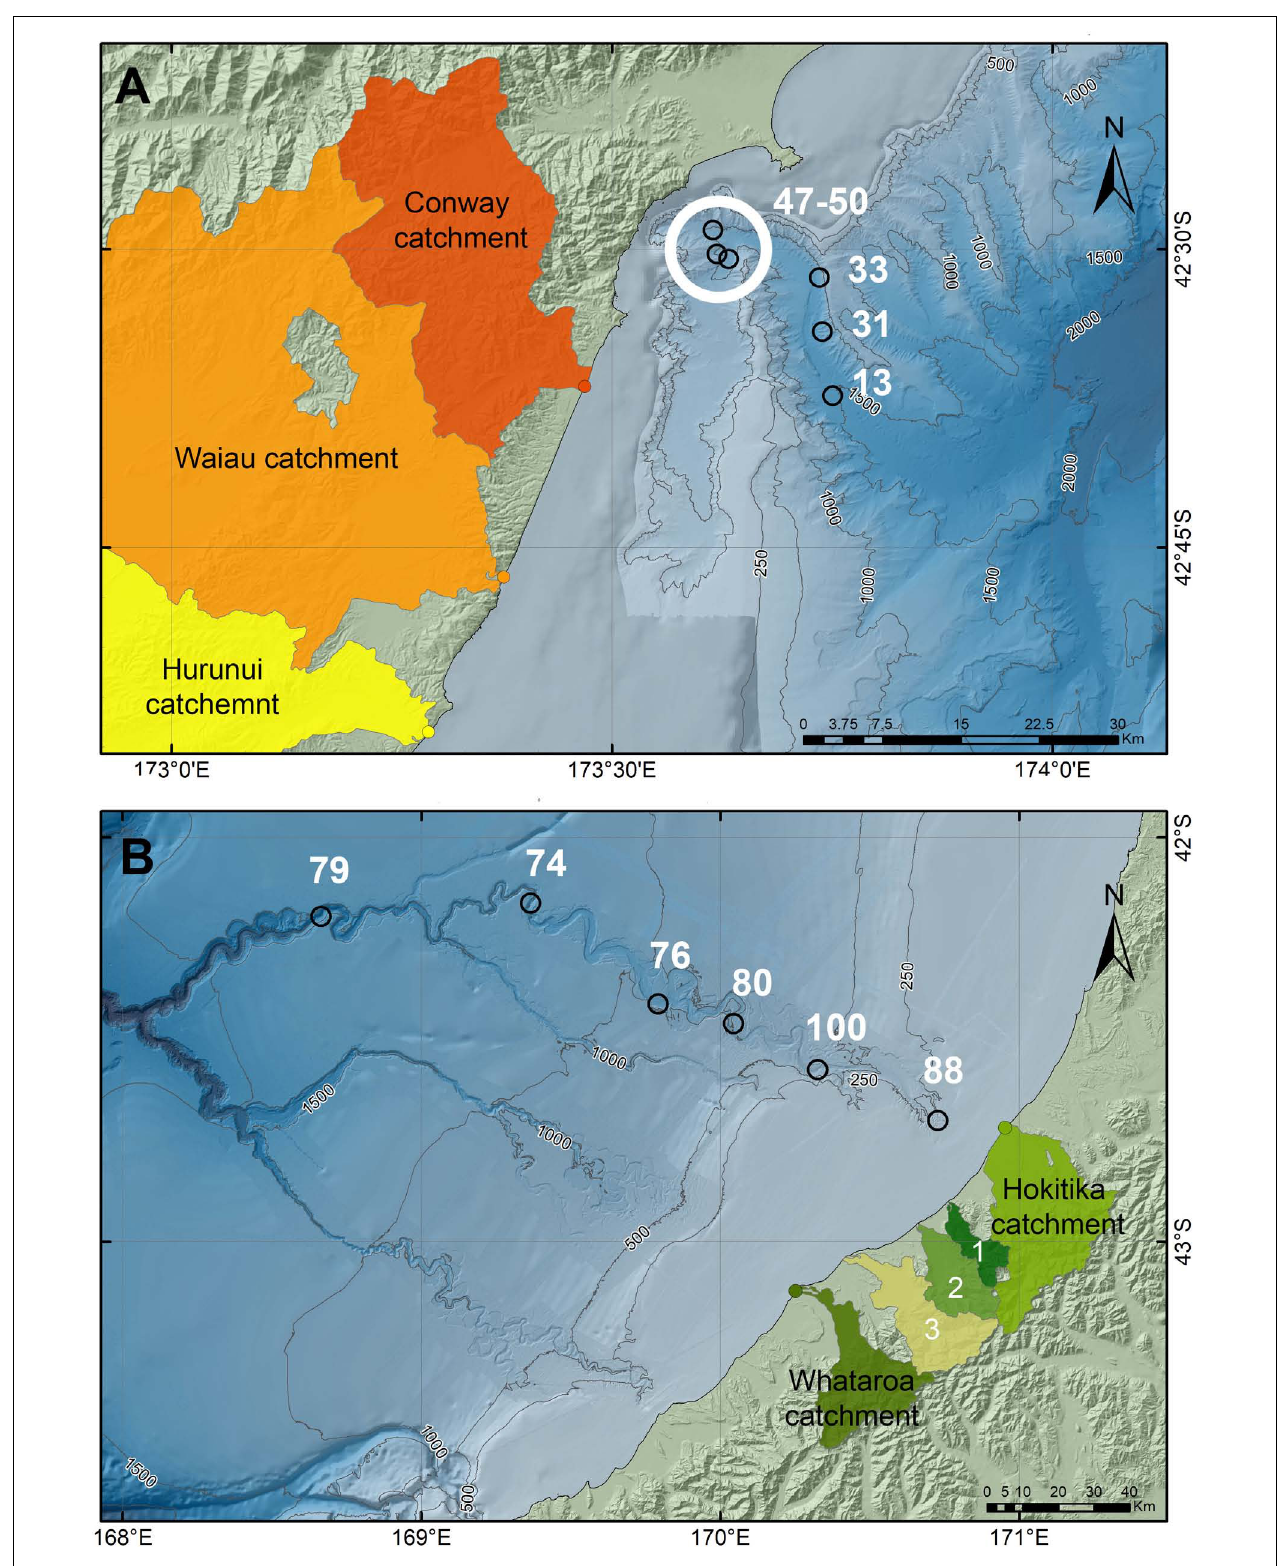
FIGURE 5 | Spatial contribution (%) of land-derived organic matter to total sediment organic matter in: (A) Kaik¯oura Canyon and (B) Hokitika Canyon. Error terms (standard deviation) were < 5% (not shown for clarity). Numbered river catchments are: (1) Mikonui, (2) Waitaha, and (3) Wanganui.